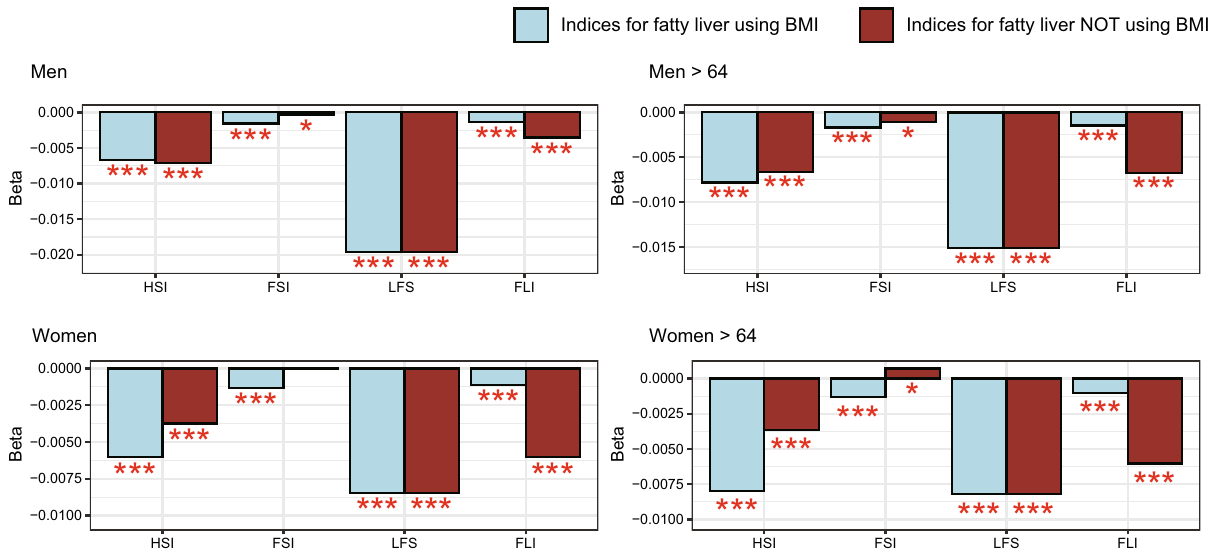
Figure 3. Relationships between SMI (ASM/BMI) and four hepatic steatosis indices. SMI and four indices are used as dependent and independent variables, respectively. Y-axes indicate beta-coefficients calculated by multivariate linear regression models including age, physical activity, current smoking, daily protein intake, hypertension, type 2 diabetes, dyslipidemia, CVD, systolic blood pressure, serum fasting glucose, total cholesterol, and serum creatinine as covariates. Brown bars indicate that the analysis was conducted using an index for fatty liver with a zero value of BMI coefficient. SMI skeletal muscle index, ASM appendicular